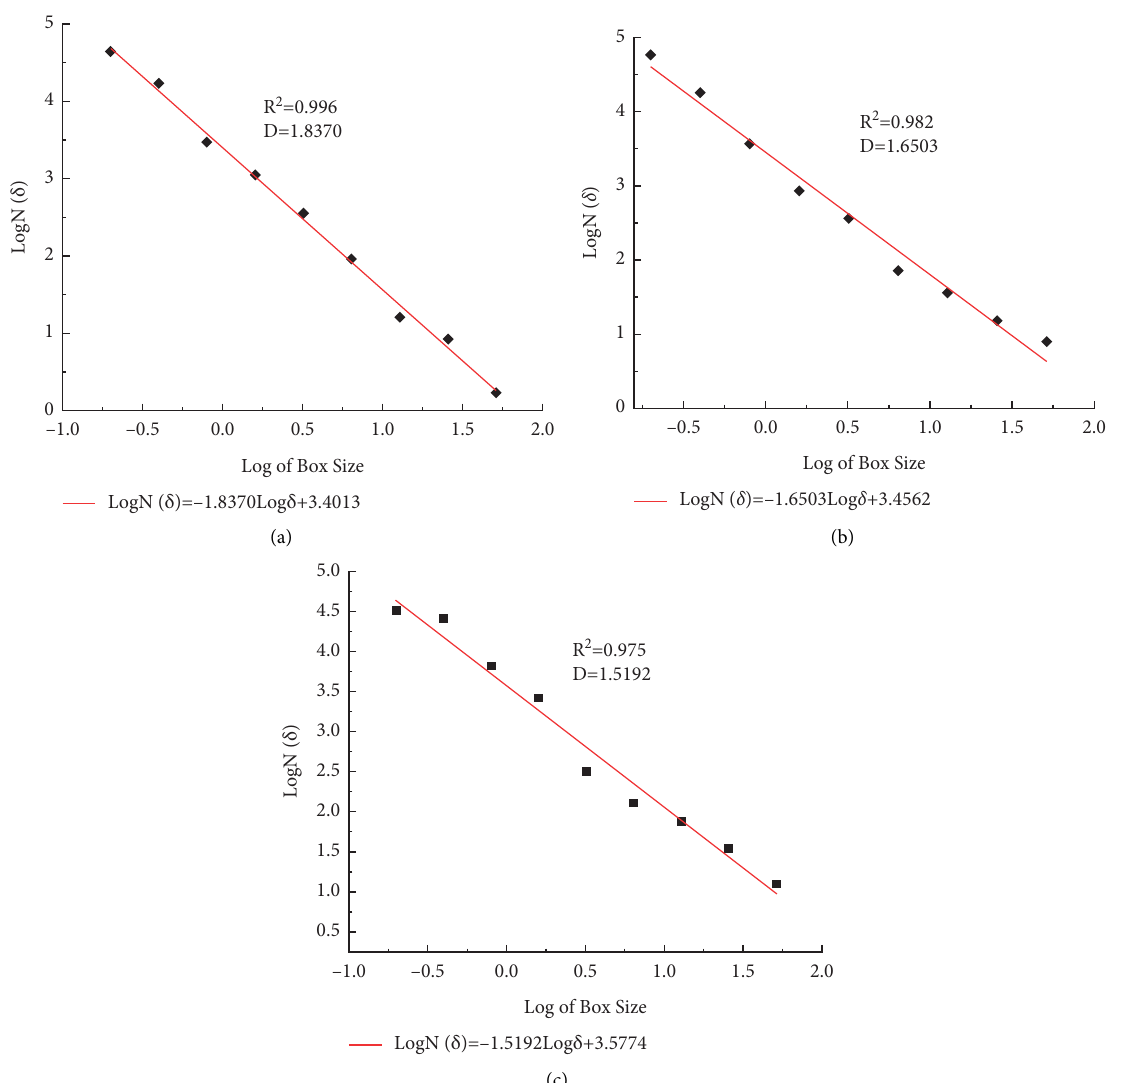
Figure 4: Calculation of fractal dimension of coal sample crack based on the fractal dimension method. Calculation of crack dimension of (a) C 1 coal sample, (b) C 2 coal sample, and (c) C 3 coal sample.